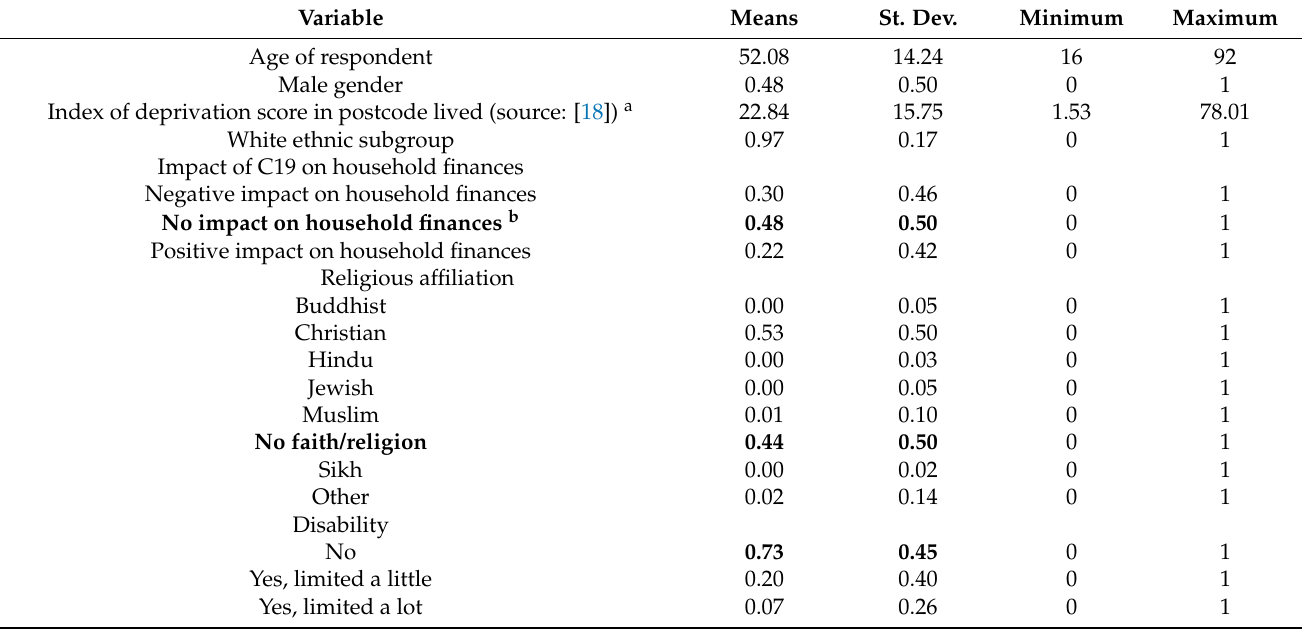
Table 1. Weighted means and standard deviations of the explanatory variables.